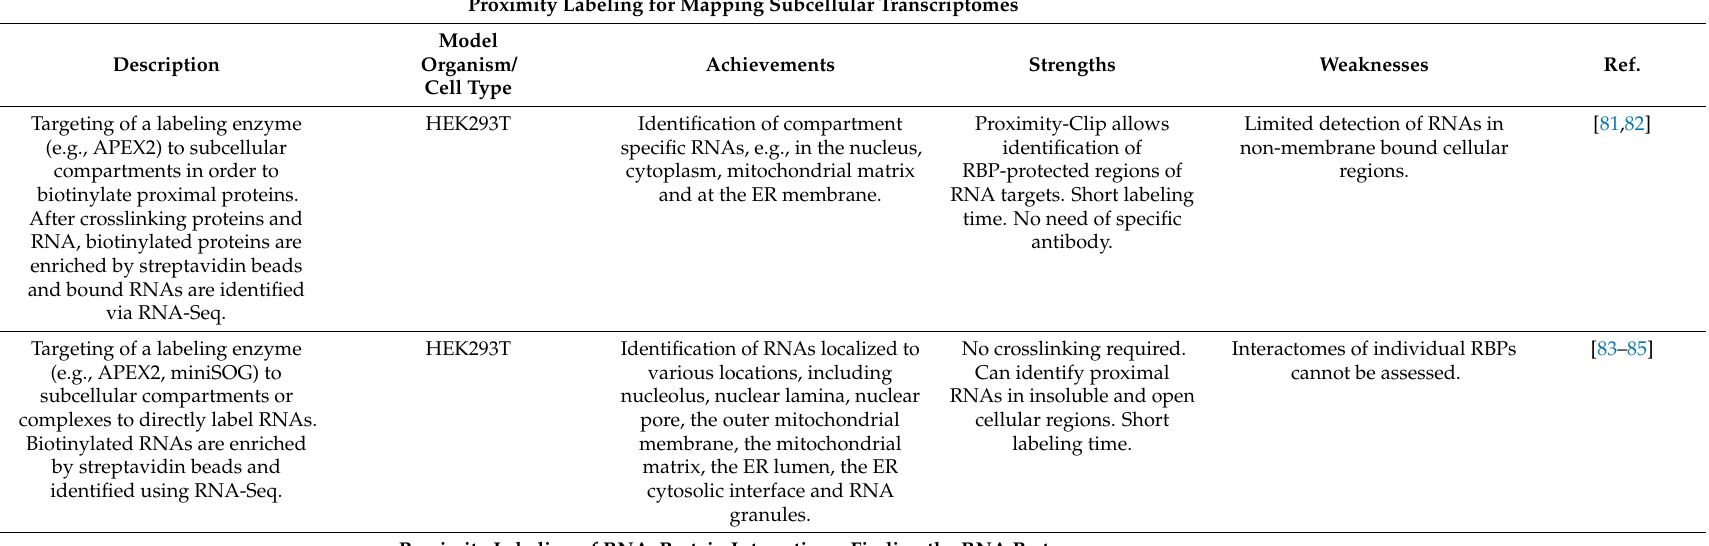
Table 1. Proximity labeling methods for the detection of RNA–protein interactions Proximity Labeling for Mapping Subcellular